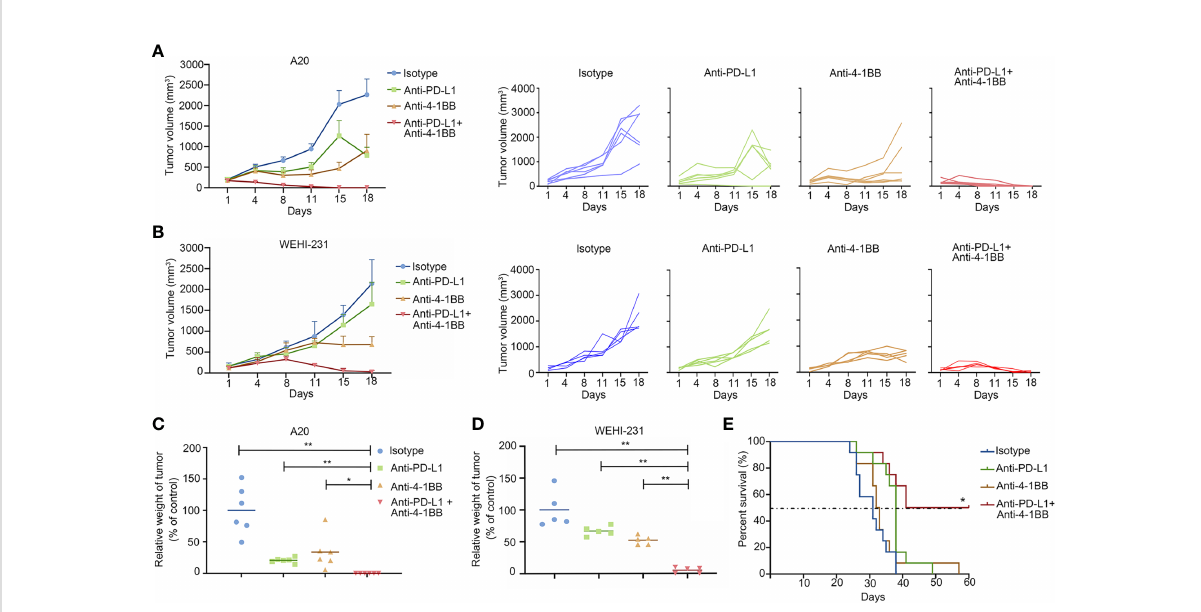
FIGURE 1 4-1BB agonism and PD-L1 blockade elicited synergistic antitumor effect in B-cell lymphoma. (A, B) The subcutaneous A20 tumor model (n = 6) or WEHI-231 tumor model (n = 5) were well-established in BALB/c mice. Tumor volume was measured twice a week. Treatment was initialized when the tumor volume reached 100 mm 3 . (C, D) Tumor weight was measured at the end of the treatment. (E) The metastatic A20 model was established to evaluate the antitumor effect on survival (n = 10). * means p-value < 0.05, and ** means p-value <